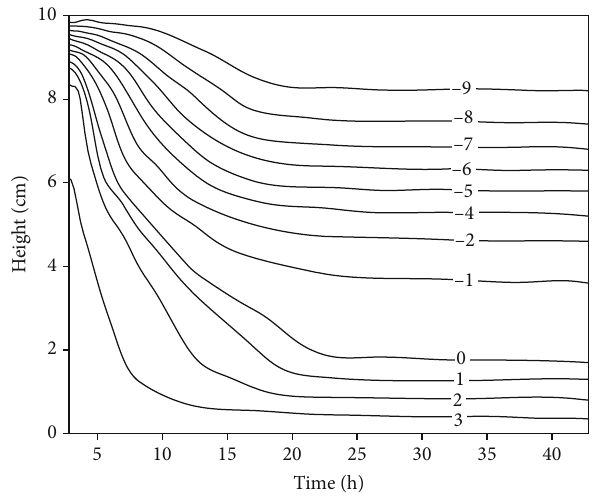
Figure 8: Temperature change process of HS.